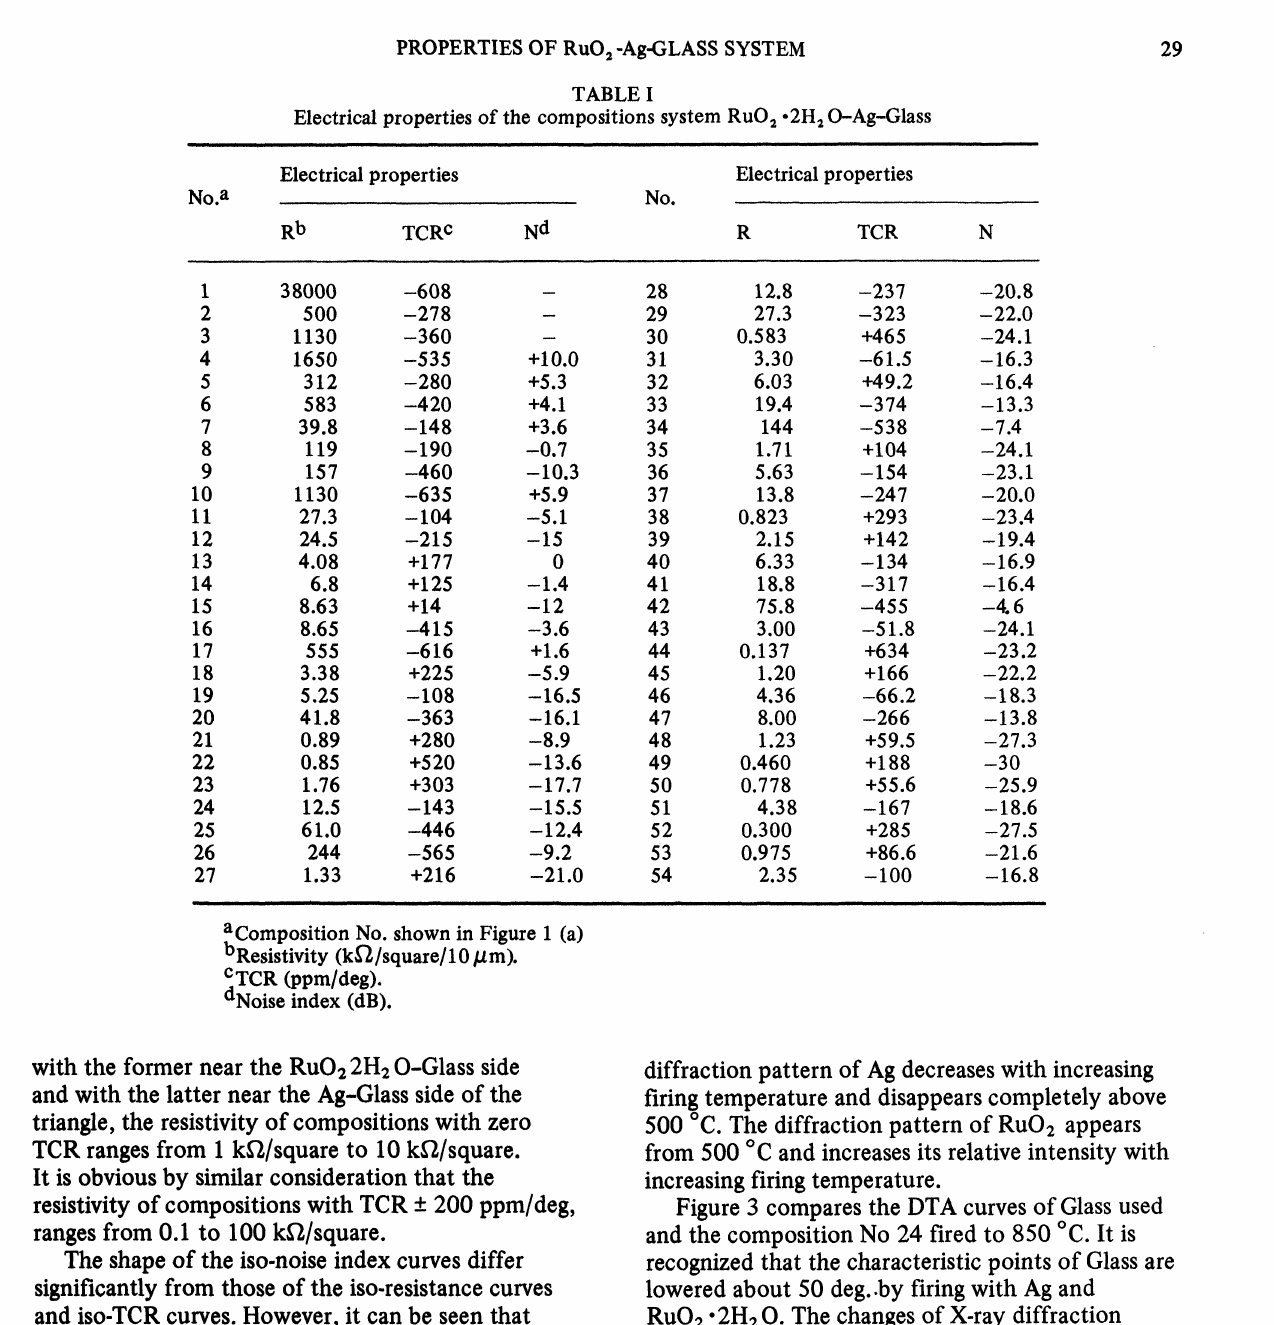
TABLE Electrical properties of the compositions system RuO